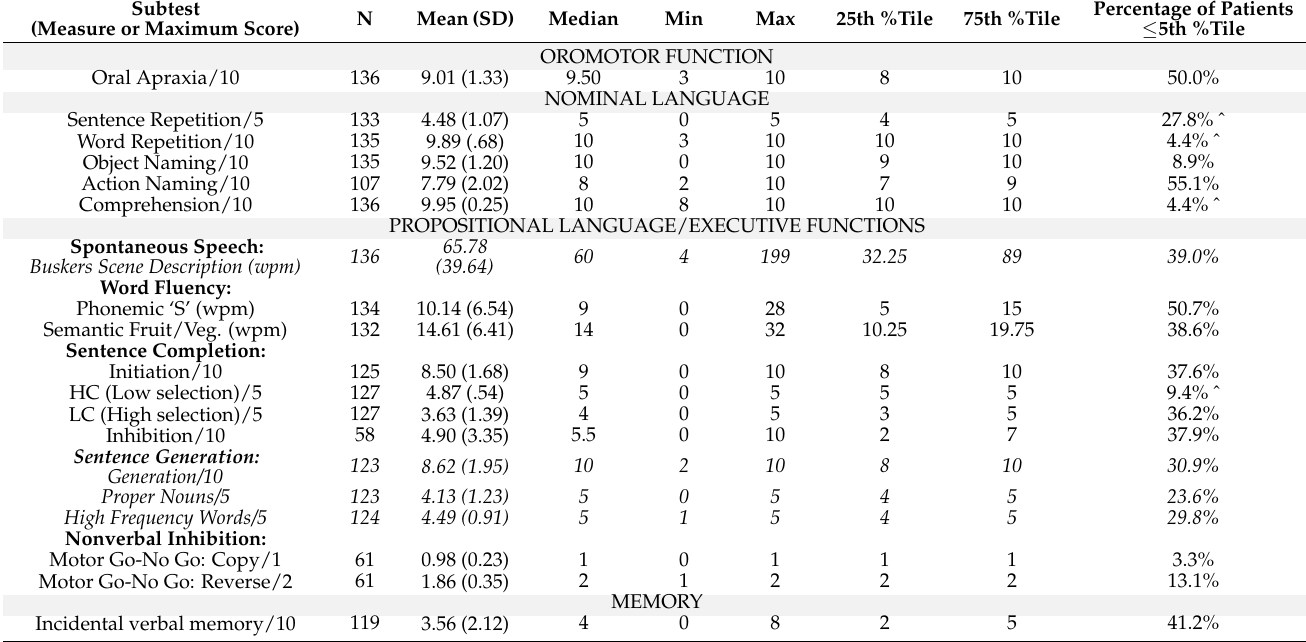
Table 3. Descriptive Statistics and Percentage of Stroke Patients Impaired for the BELS subtests.